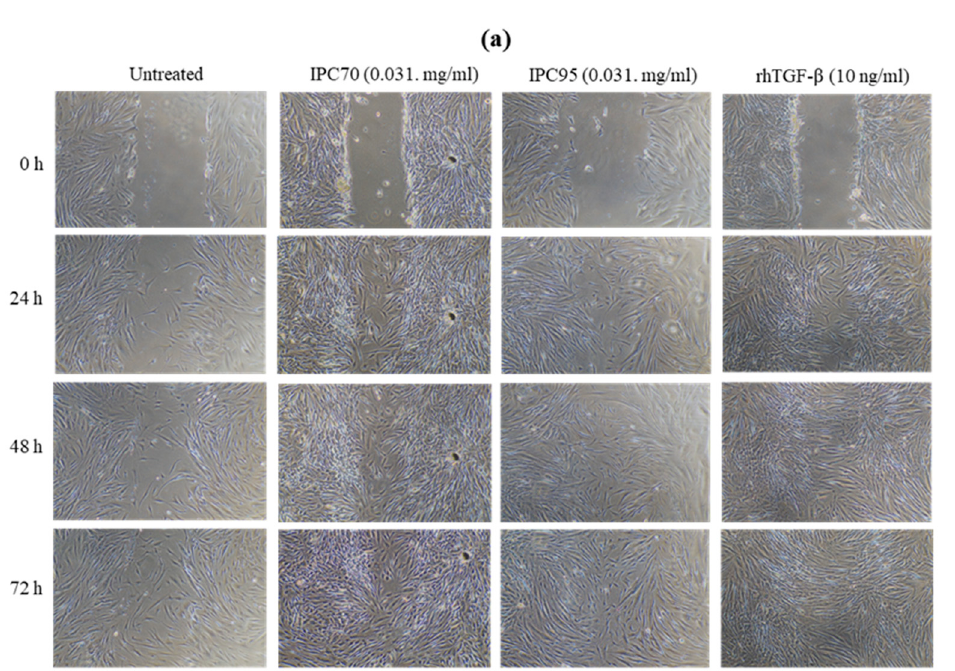
Figure 4. In vitro wound healing of CCD-986sk cells treated with IPC70 and IPC95 extracts. ( a ) Scratch wounds were observed using an inverted light microscopic (magnification ×100). ( b ) The percentage of cell-free or wound area was measured using the Image J program. The data are means ± SD from three independent experiments. The superscript letters ( a,b,c ) indicate a significant difference at p < 0.05; ( a ) treated cells at 24, 48, and 72 h were compared with treated cells at 0 h; ( b ) rhTGF- β -treated cells were compared with IPC-treated cells; ( c ) IPC70-treated cells were compared with IPC95-treated cells. 2.6. Effect of Ipomoea pes-caprae Extracts on Production of Type I Collagen and Expression of COL1A1, TGFB1, and FGF2 Genes The effects of IPC extract on type I collagen production in CCD-986sk cells were determined using a sandwich enzyme immunoassay [20]. As shown in Figure 5a, the production of type I collagen was increased significantly compared with untreated cells, following treatment with rhTGF- β and IPC extracts ( p < 0.05). Type I collagen levels after treatment with 10 ng/mL of rhTGF- β , and 0.031 and 0.062 mg/mL of IPC70 were 8.55 ± 1.25, 6.55 ± 0.75 and 3.43 ± 0.68 ng/mL, respectively. The highest level of type I collagen was produced with the rhTGF- β treatment, while IPC95 exposed cells produced the lowest levels of type I collagen. IPC70 enhanced the production of type I collagen to a greater level than IPC95.